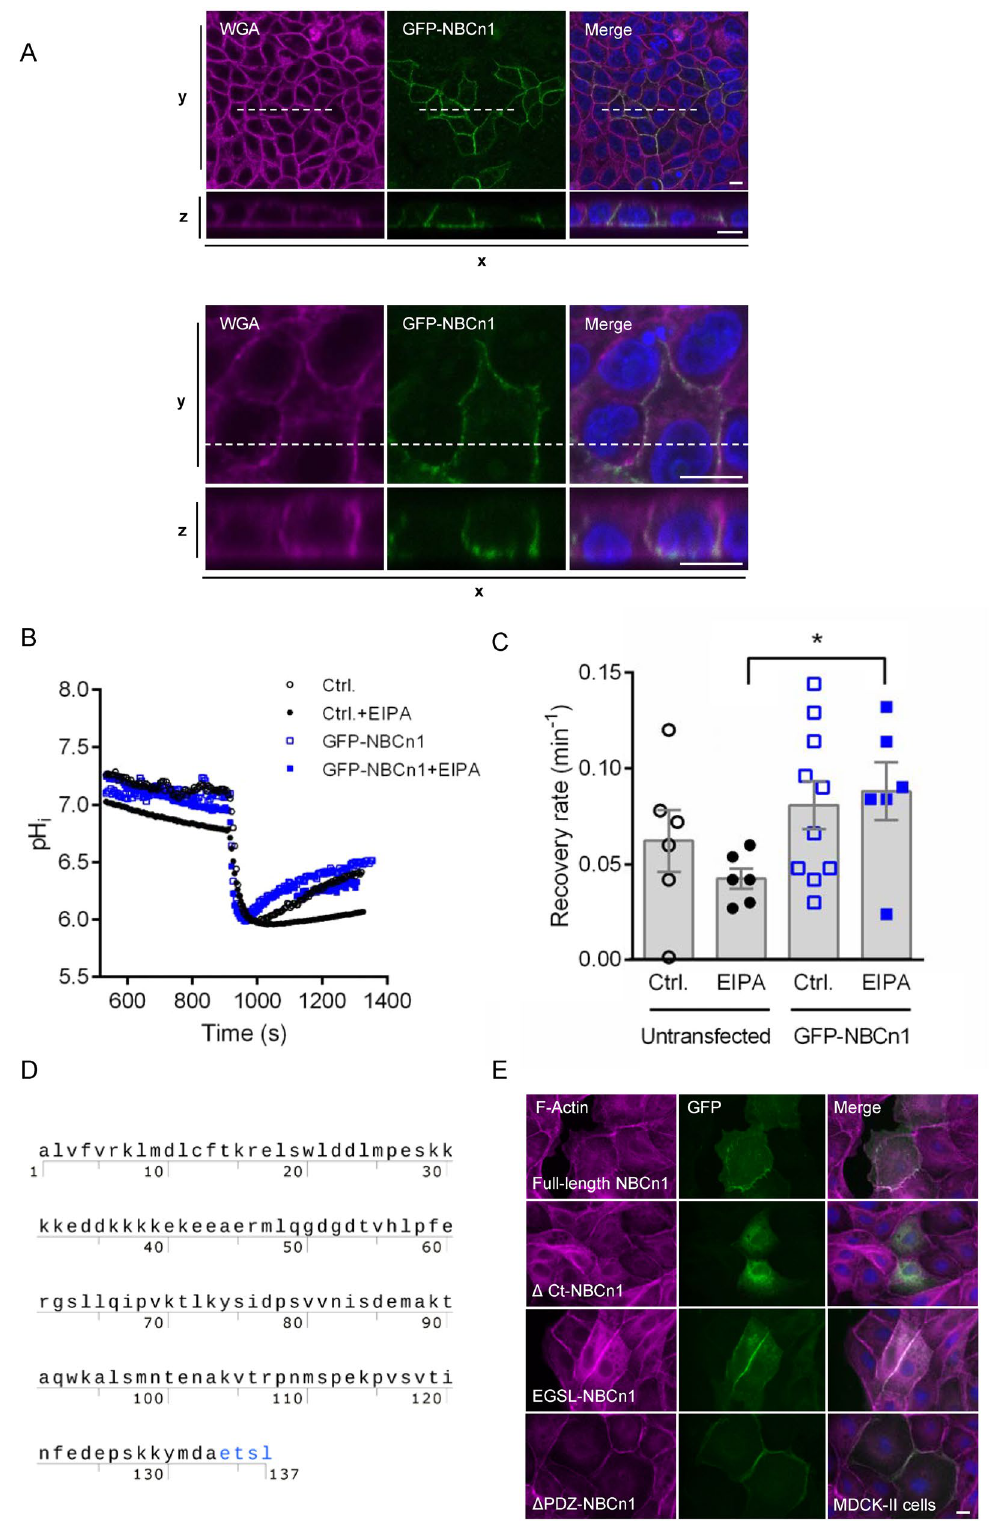
Figure 2. GFP-NBCn1 membrane localization and function. ( A ) GFP-NBCn1 localizes to the basolateral cell surface. MDCK-II cells transiently transfected with GFP-NBCn1 were cultured to 100% confluency and maintained in culture for 12 days before fixation. Cells were stained with wheat germ agglutinin (WGA) and DAPI prior to confocal imaging. Bottom rows are xz-scans of the dashed line shown in top rows (xy-scans). Upper and lower panel are low- and high magnification images, respectively. Scale bars: 10 µ m. Representative images from 4 independent experiments are shown. ( B , C ) GFP-NBCn1 is a functional net acid extruder. Capacity for net acid extrusion after an NH 4 Cl-prepulse-induced intracellular acidification was assessed by